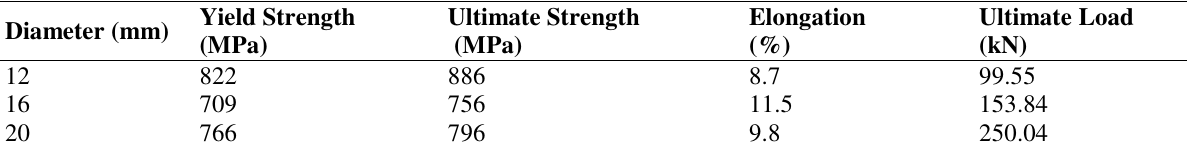
Properties of Dowel Bars